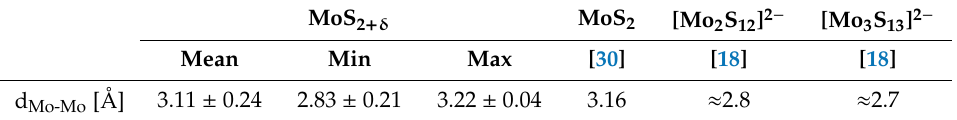
Table 3. Mo-Mo distance of MoS 2 + δ compared with MoS 2 [30] and the cluster anions [Mo 2 S 12 ] 2 −